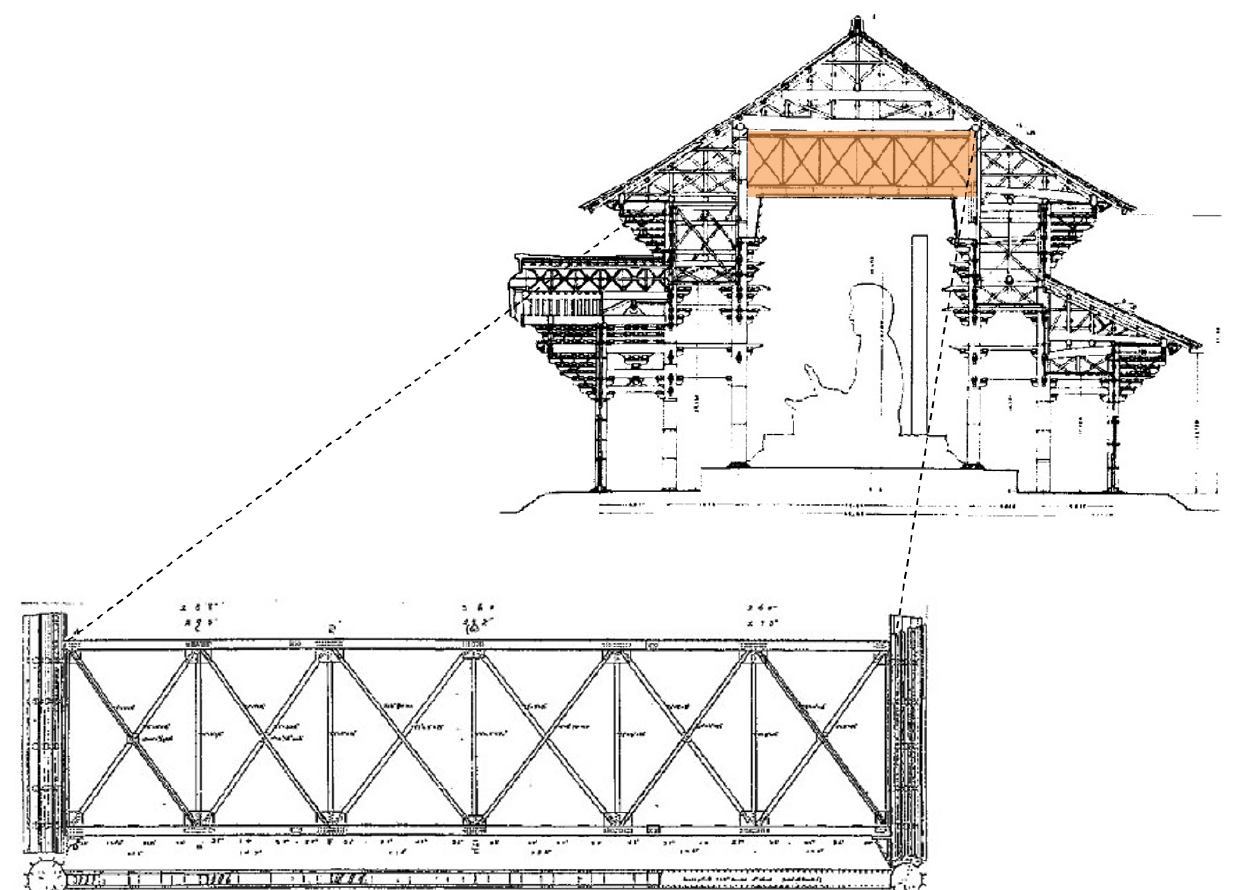
Figure 21. Daibutsuden Hall of Todaiji Temple: A Sectional Detail of Restored Parts and Box Truss after the Meiji Restoration Project [25], the truss part annotated by authors.